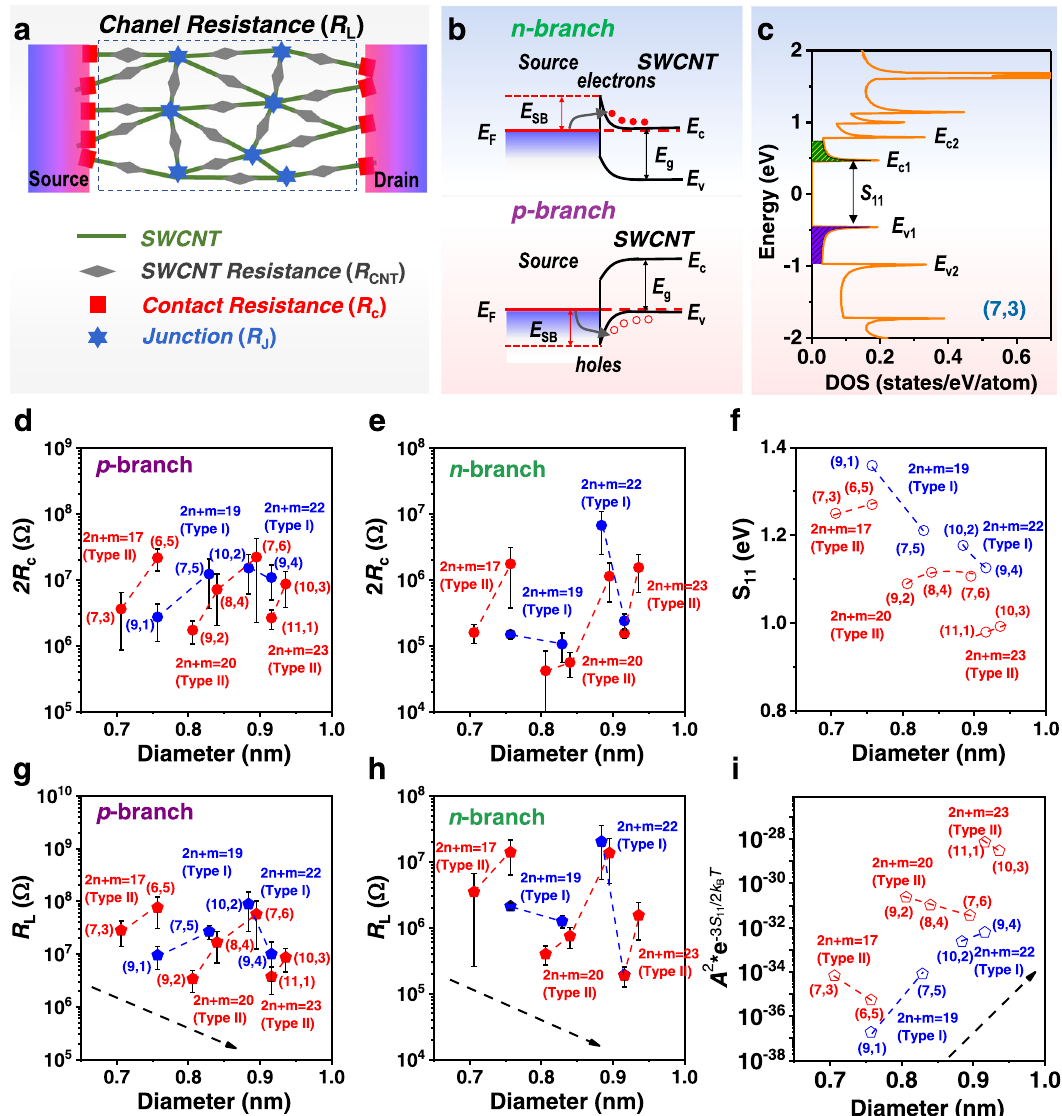
Fig. 4 | Resistance analysis of TFTs constructed by different single-chirality diameter, which were extracted from the Kataura plot in Ref. 14 . g , h Plots of the SWCNTs. a Schematic diagram of carrier transport from the source to drain elec- channel resistance ( R L ) of the p -branch ( f ) and n -branch ( g ) of SWCNT-TFTs as a function of their diameter. i Plots of the relative junction conductance G NT 0 ij as a trode and composition of the contact resistance (2 R c ) and channel resistance ( R L = R J + R CNT ). b Schematic diagram of the construction of a Schottky barrier ( E SB ) function of SWCNT diameter deduced from Eq. (6) at room temperature ( k B T = between an electrode and SWCNTs for electrons and holes. c Density of states 26meV). Blue and red symbolsrepresent TypeI and Type II SWCNTs, respectively. (DOS) of (7, 3) SWCNTs 47 , in which the fi rst conduction and valence bands are Dashedlinesareintroducedasguidestotheeye.Theblackdashedarrowsshowthe change trend of the channel resistance or relative junction conductance with indicated by the shaded areas. d , e Plots of the contact resistance (2 R c ) of the p - increasing diameter. Error bars in ( d ), ( e ), ( g ) and ( h ) are the standard deviation of branch ( d ) and n -branch ( e ) of SWCNT-TFTs as a function of their diameter. f The fi rst bandgap (S 11 values) of the single-chirality species as a function of their